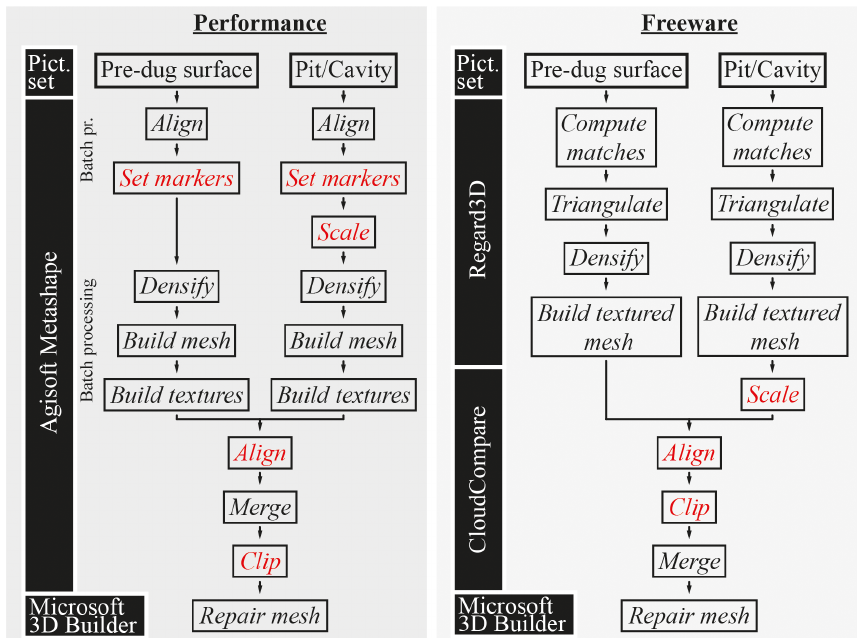
Figure 5. Performance and freeware workflows as applied in this study and the computer programs used. Non- or semi-automated steps are shown in